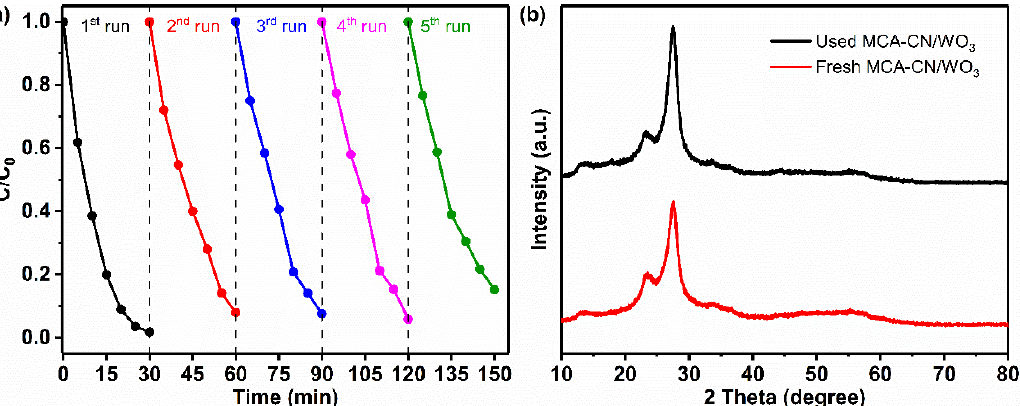
Figure 14. ( a ) Recycling tests of MCA-CN/WO 3 in MB degradation and ( b ) XRD patterns of fresh MCA-CN/WO 3 and used MCA-CN/WO 3 .